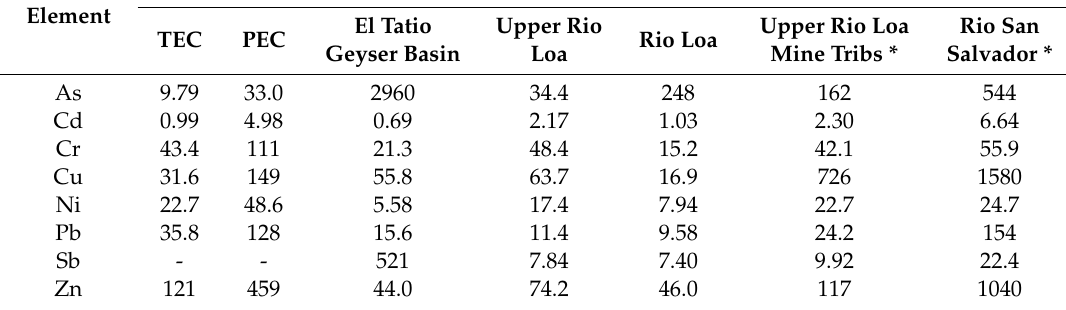
Table 1. Comparison of trace metal concentrations along the Rio Loa r, mine a ff ected tributaries, and sediment from the El Tatio Geyser Basin to consensus based aquatic threshold values; data from Wilson [32]. See Figure 1 for reach